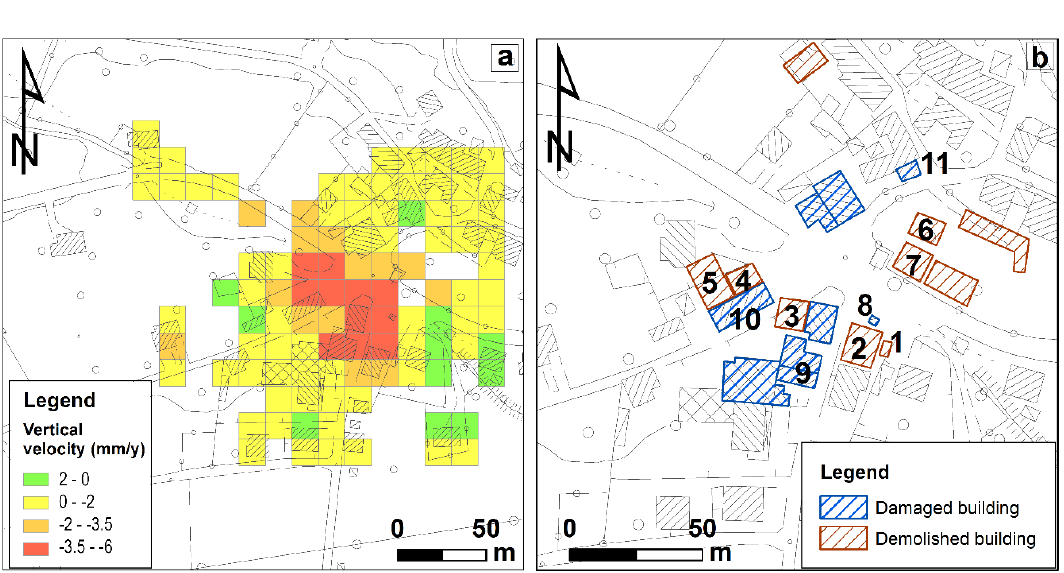
Figure 10. ( a ) Vertical velocities in mm/y computed using Equation (1) on the interferometric available data for the period 2012–2016; ( b ) demolished buildings (brown) and actually damaged houses (blue) in the central part of the study area. Numbers were assigned to the houses described further on in the text and in Figure 11.